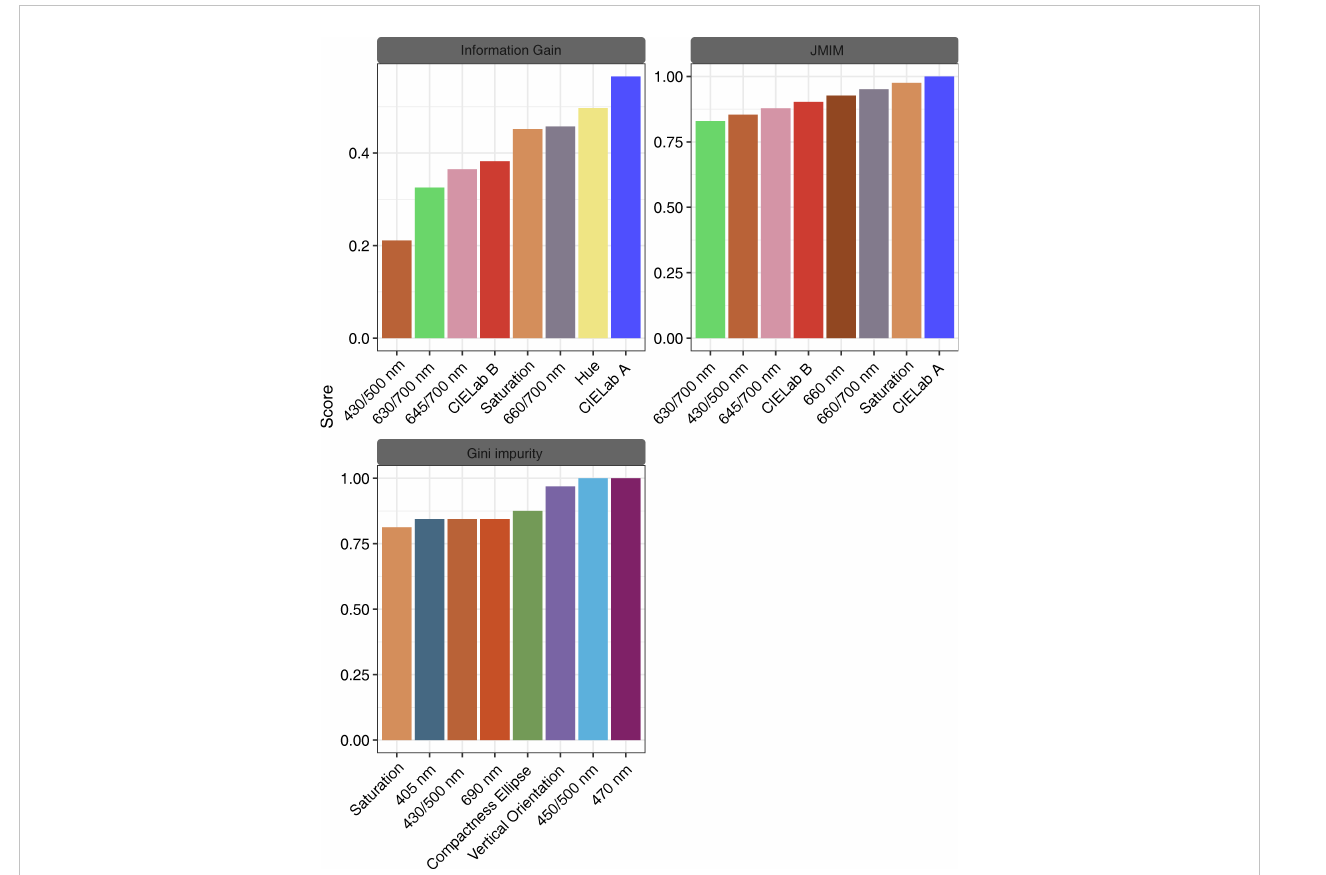
FIGURE 8 Feature importance scores of three feature fi ltering methods for information gain, JMIM, and Gini impurity.